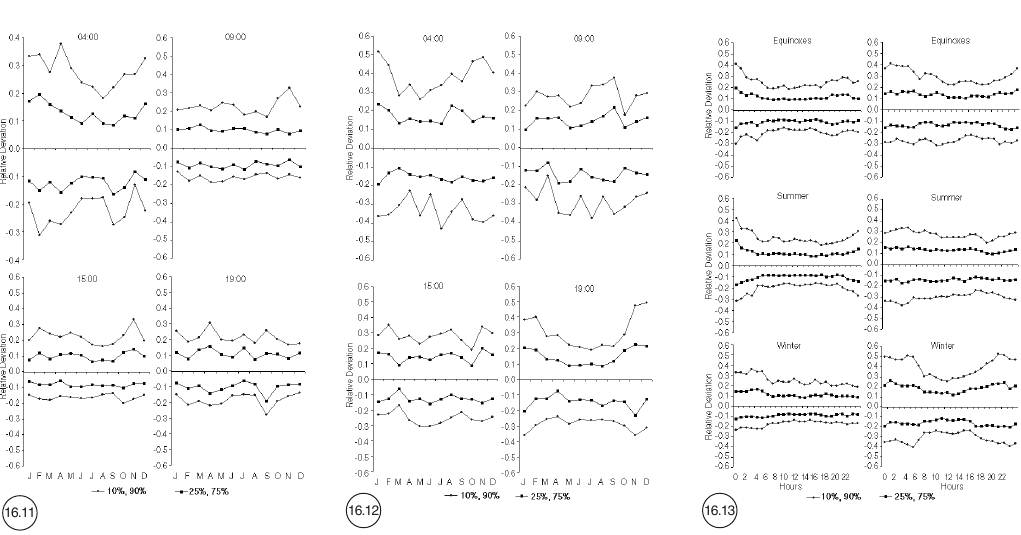
Fig. 16.11. Plots of quartiles and deciles of TEC variability at randomly selected hours. Data measured at years of low solar activity. Fig. 16.12. Plots of quartiles and deciles of TEC variability at randomly selected hours. Data measured at years of high solar activity. Fig. 16.13. Diurnal variation of quartiles and deciles of TEC variability at low (left) and high (right) solar ac- tivity and different